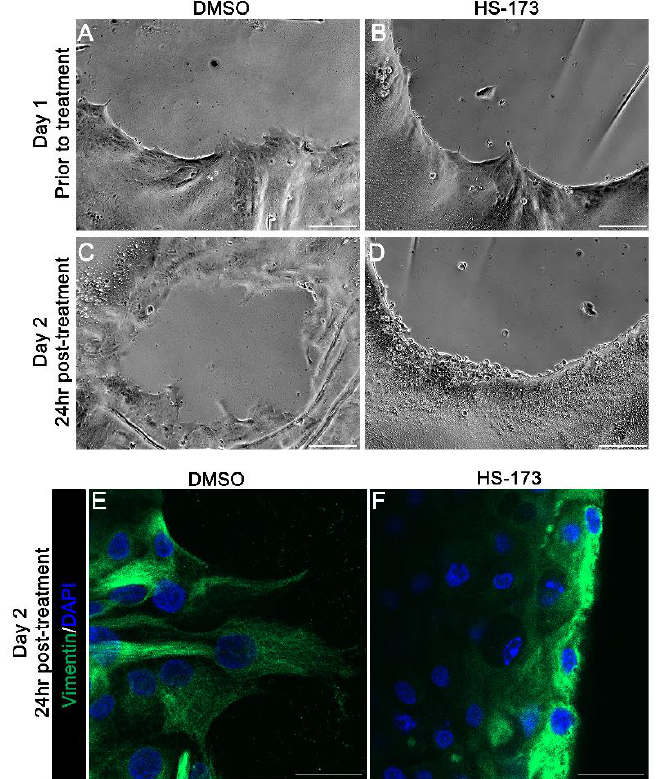
Figure 3. p110 α is required to maintain the extension of vimentin-rich lamellipodia of leader cells. ( A – F ) Ex vivo post-cataract surgery explants were treated with vehicle (DMSO) or HS-173 to inhibit p110 α from Day 1 for 24 h (Day 2 post-injury). ( A , B ) Phase contrast imaging on Day 1 shows the extension of protrusions by leader cells at the wound edge prior to treatment. ( C , D ) In contrast, phase contrast imaging on Day 2 (24 h post-treatment) revealed that HS-173-treated leader cells failed to maintain protrusions compared to vehicle controls. ( E , F ) Day 2 explants following 24 h of treatment were immunolabeled for vimentin (green) and counterstained for DAPI (blue). Confocal images revealed that maintenance of vimentin-rich lamellipodia extensions was blocked by HS-173 treatment ( F ) compared to vehicle controls ( E ). Magnification bars = 50 μ m ( A – D ) and 20 μ m ( E , F ).